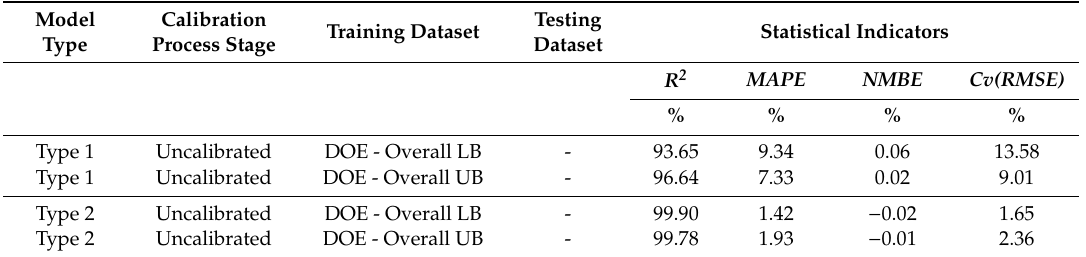
Table 6. Model training on the design phase data (uncalibrated models, a priori data)